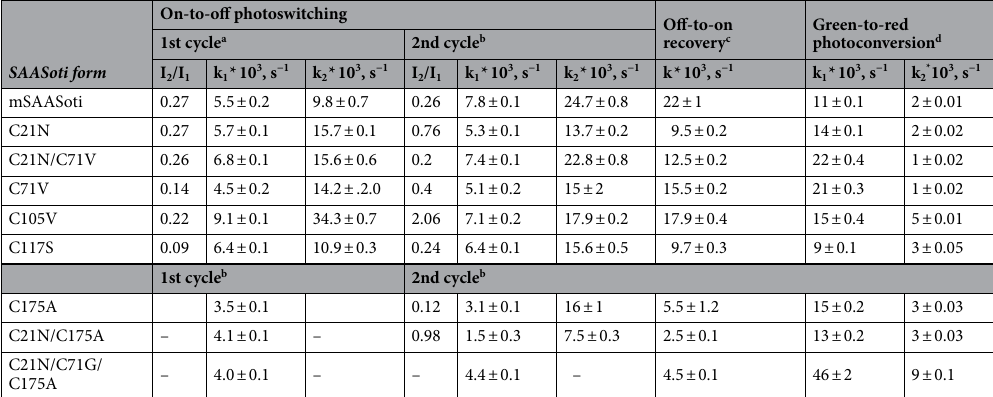
Table 3. Kinetic parameters for the on-to-off photoswitching reaction, off-to-on recovery and green-to-red photoconversion calculated for different SAASoti mutant forms. a Photoswitching kinetics is described by Eq. (2). b Photoswitching kinetics is described by Eq. (3). c Thermal relaxation recovery as absorption at 509 nm is described by Eq. (4). d Photoconversion kinetics is described by Eq. (1).